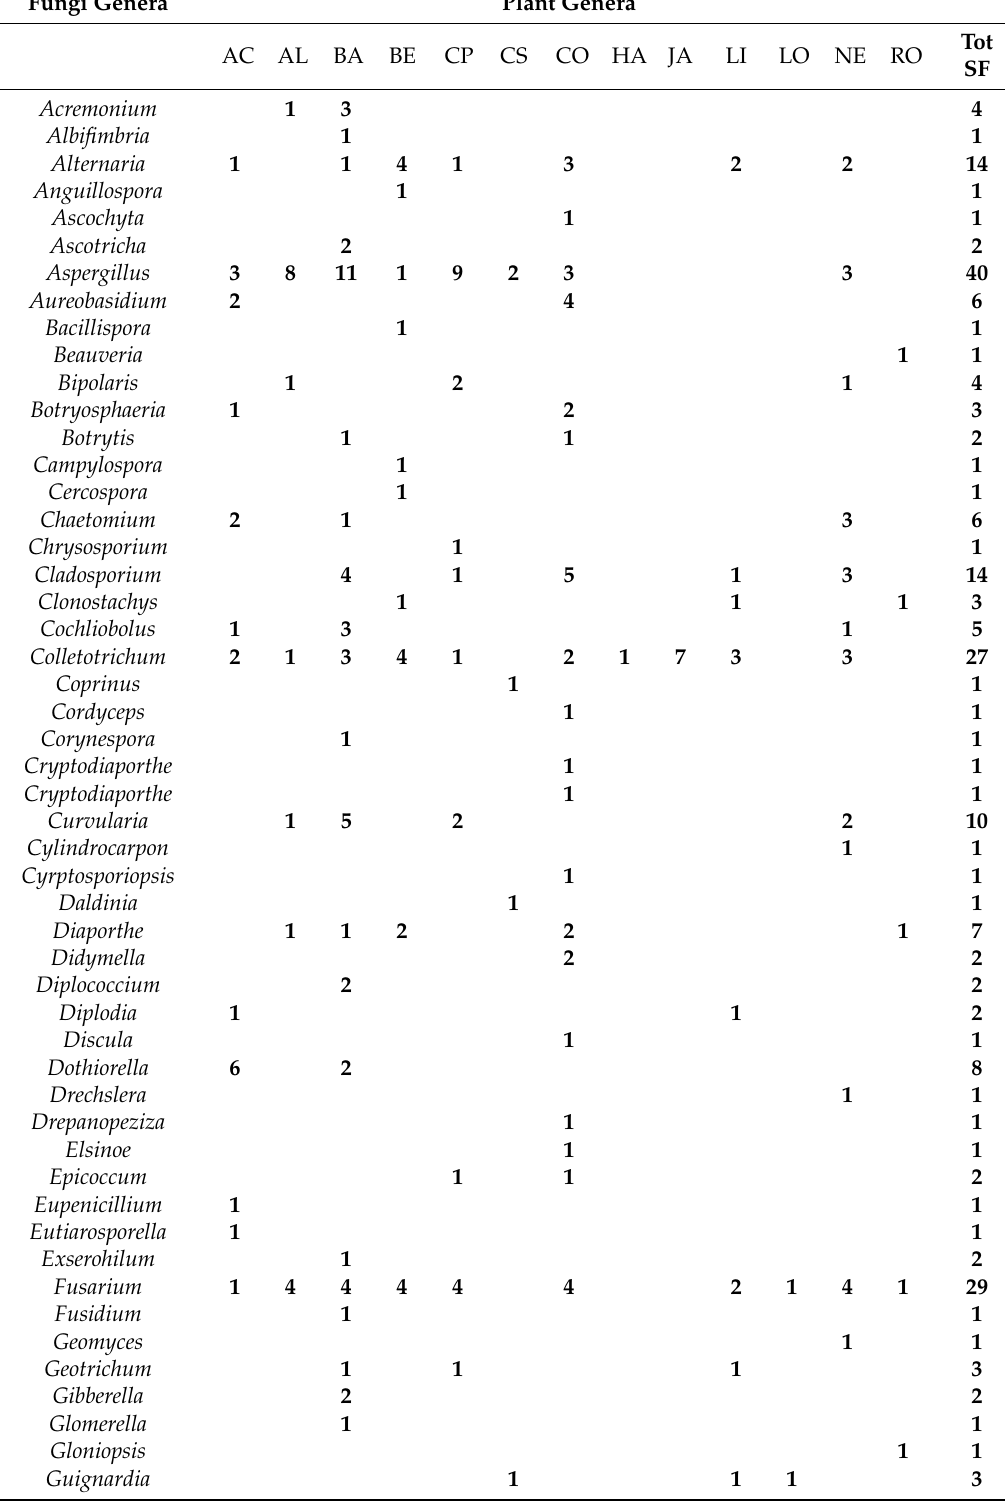
Table 1. Endophytic fungi isolated from Acacia (AC) , Albizia (AL). , Bauhinia (BA) , Berberis (BE) , Caesalpinia (CP) , Cassia (CS) , Cornus (CO), Hamamelis (HA) , Jasminus (JA) , Ligustrum (LI) , Lonicera (LO) , Nerium (NE) , Robinia (RO). Columns report the number of isolated fungal species. The total number of records calculated per fungal genus is indicated as Tot. SF. The total number of records per plant genera is indicated as Tot. SP. Fungal genera are sorted by alphabetic